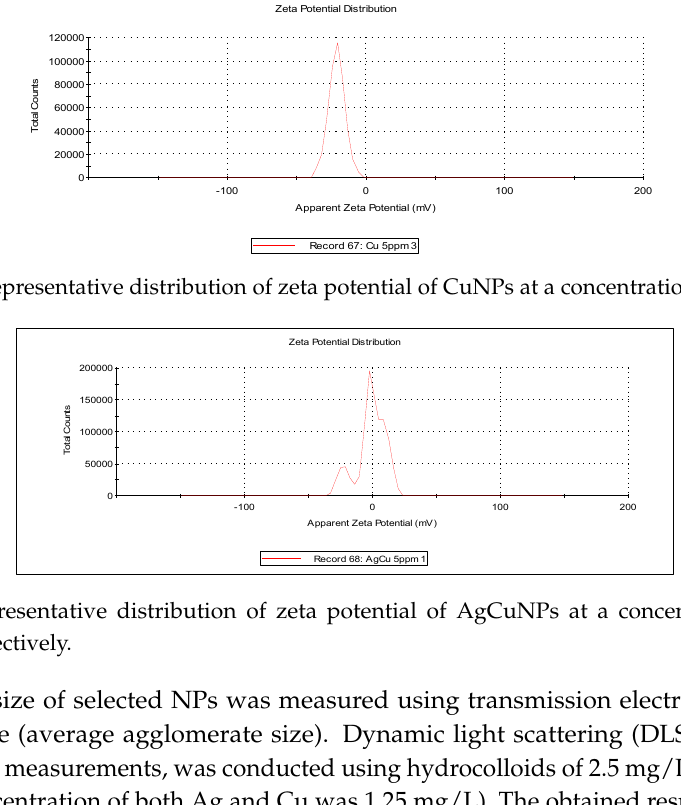
Figure 6. Representative distribution of zeta potential of AgNPs at a concentration of 5 mg/L.